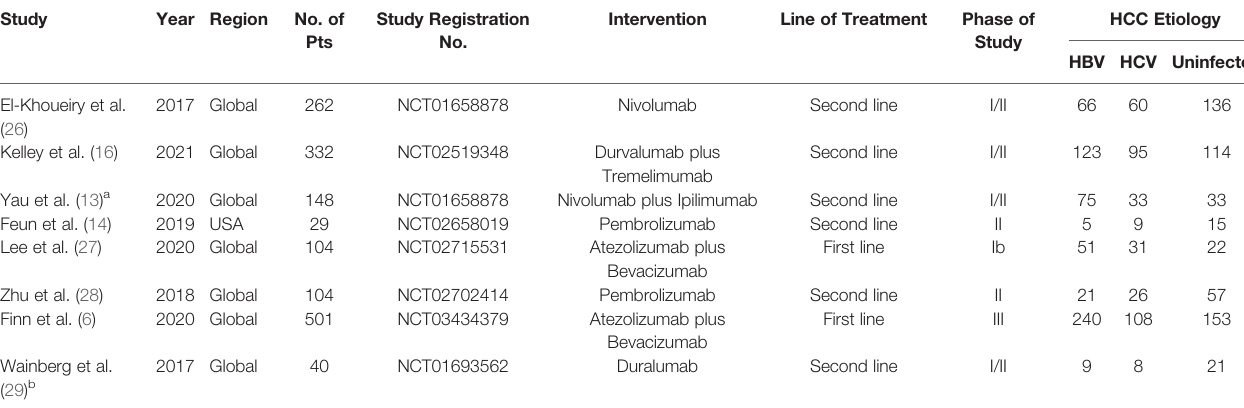
TABLE 1 | Basic characteristics of eligible studies.